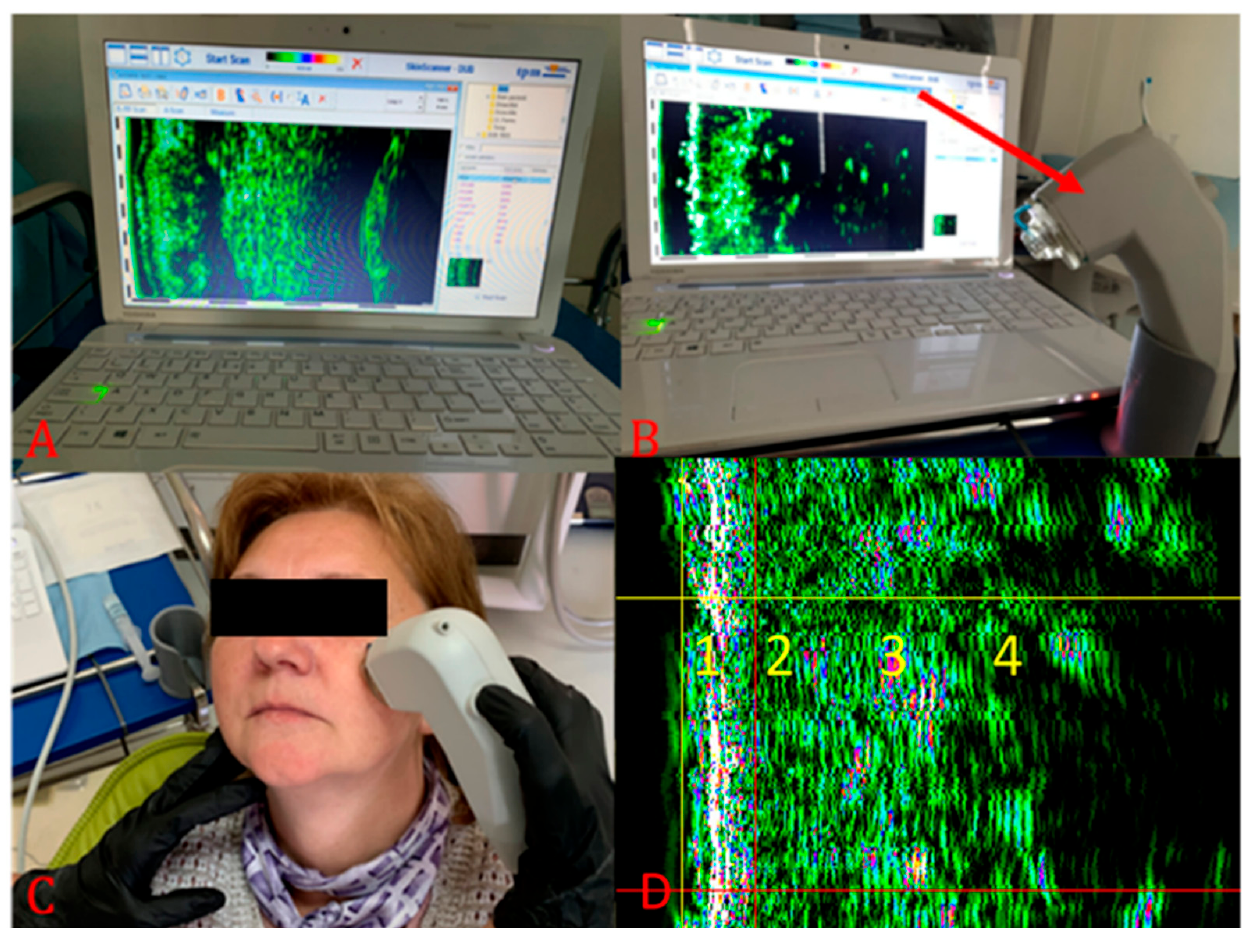
Figure 1. HFU assessment in zygomatic skin area. ( A ) HFU (DUB cutis, Taberna Pro Medicum, Lüneburg, Germany); ( B ) the transducer with a 22 MhZ frequency (red arrow); ( C ) assessment of the ecographic measurements; ( D ) HFU skin structures: 1—epidermis, 2—aged dermis, 3—healthy dermis, 4—hypodermis.